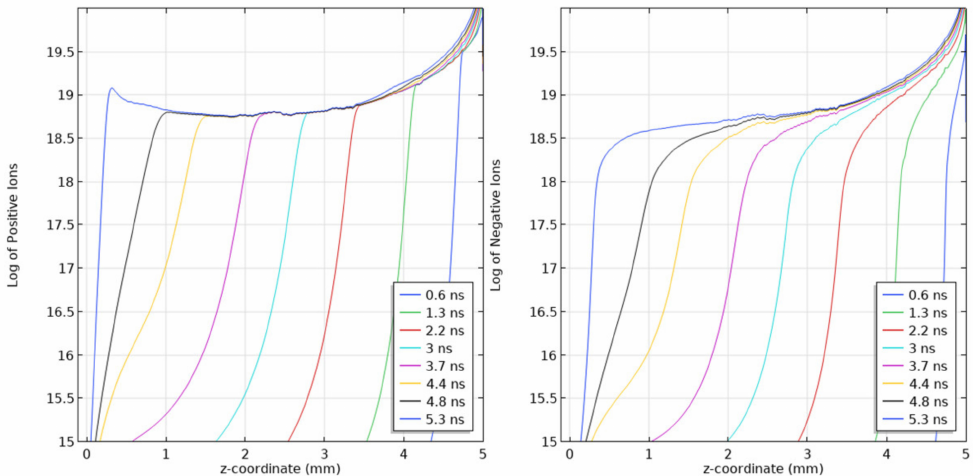
Figure 15. Line diagrams along the symmetry axis of the log of the Positive Ion Density profile ( left ) and the Negative Ion Density profile ( right ) for a streamer propagating in a 5 mm SF 6 gap at a pressure of 10 kPa. Applied voltage of 5 kV. Scaling parameter for density profiles: 20 on logarithmic plot represents a density value of 10 20 m − 3 .